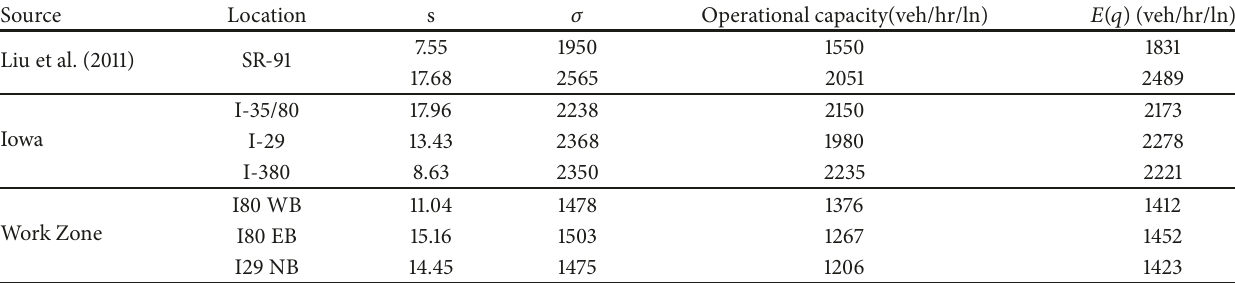
Table 2: Operational capacity, mean and parameters of capacity distribution from an existing study and field data.